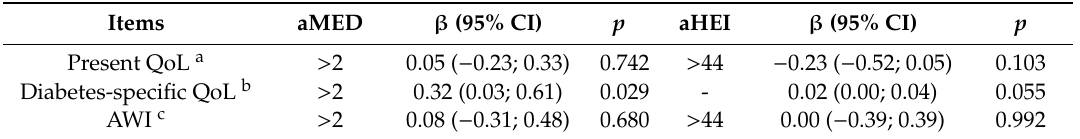
Table 3. Multivariable analysis of the Audit Diabetes-Dependent Quality of Life (ADDQoL-19) questionnaire with the alternate Mediterranean Diet Score and alternate Healthy Eating